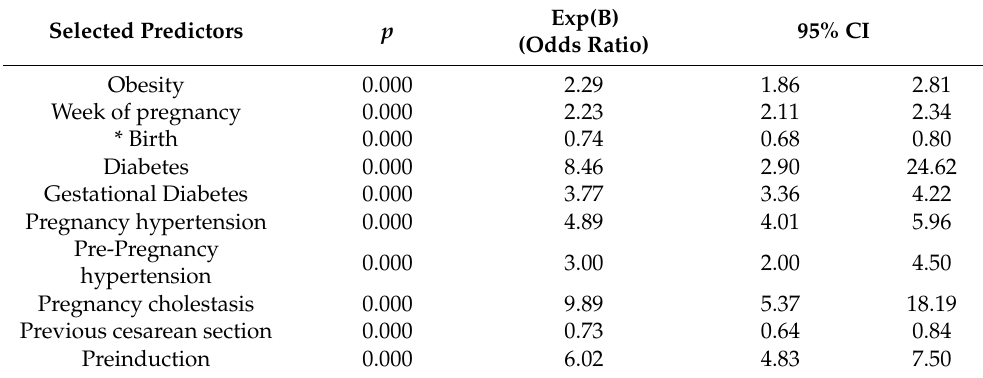
Table 4. Multivariate logistic regression analysis of factors affecting the performance of labor